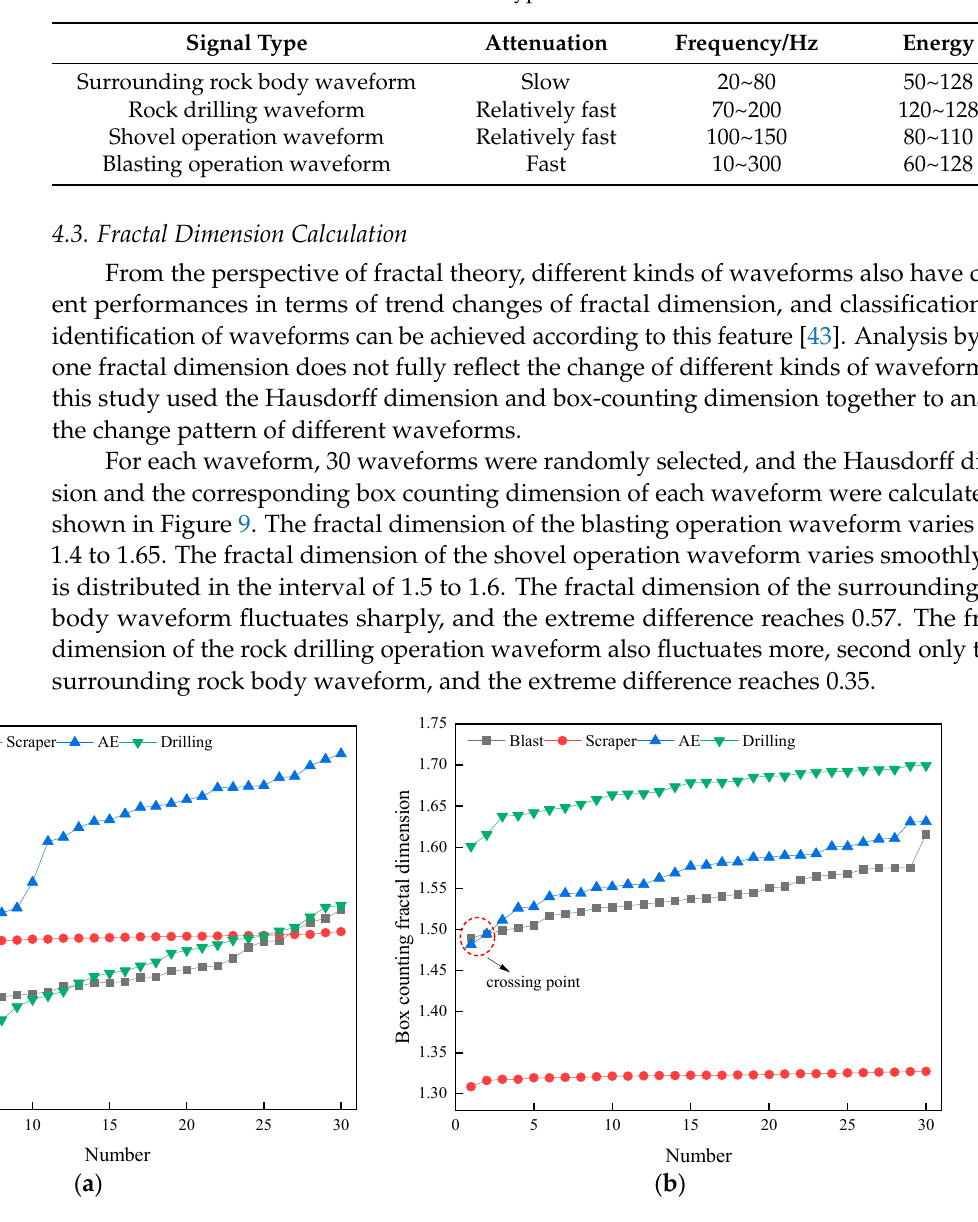
Figure 9. The fractal dimension trend of four waveforms: ( a ) Hausdorff dimension, ( b ) box counting dimension.